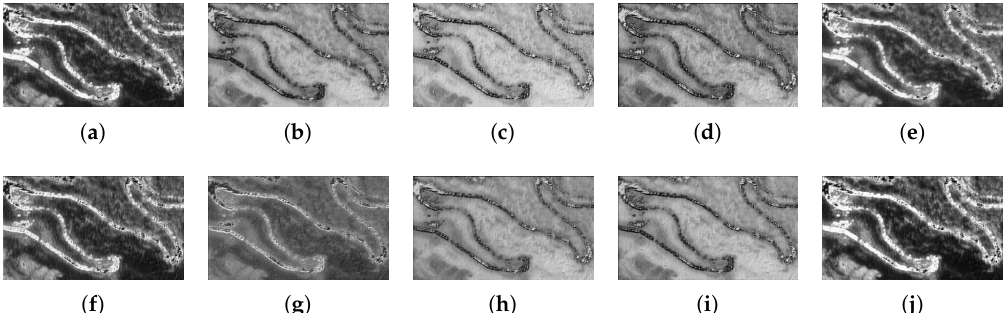
Figure 14. Feature images of Forest Dataset extracted from different neurons of the third layer. ( a ) feature image from the 1st neuron; ( b ) feature image from the 3rd neuron; ( c ) feature image from the 5th neuron; ( d ) feature image from the 7th neuron; ( e ) feature image from the 9th neuron; ( f ) feature image from the 11th neuron; ( g ) feature image from the 13th neuron; ( h ) feature image from the 15th neuron; ( i ) feature image from the 17th neuron; ( j ) feature image from the 19th neuron. Table 4. Quantitative comparison of the Forest Dataset with other methods. Different